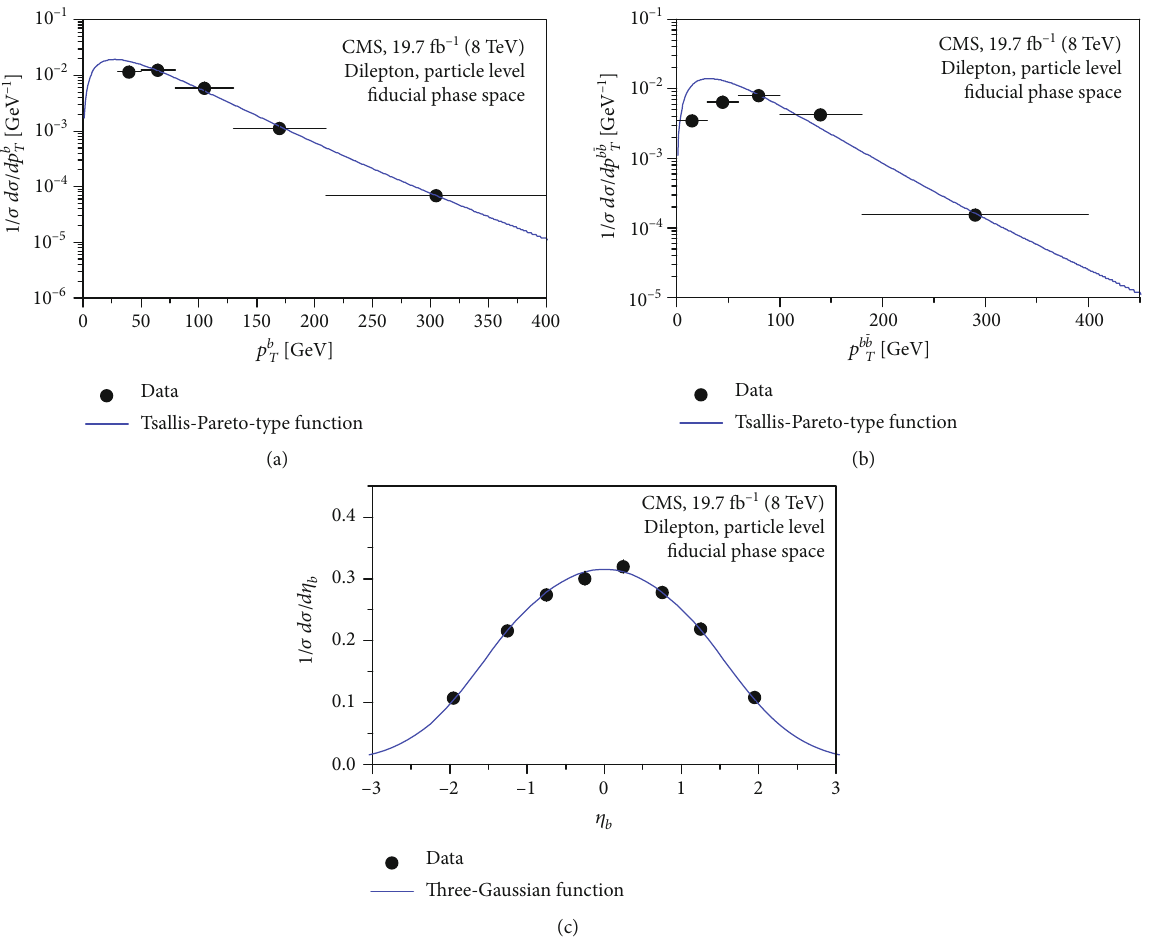
Figure 16: The same as Figures 1 and 5, but showing the results of b and b (cid:1) b produced in pp collisions at the particle level in the fi ducial phase ffiffi p s = 8 space at